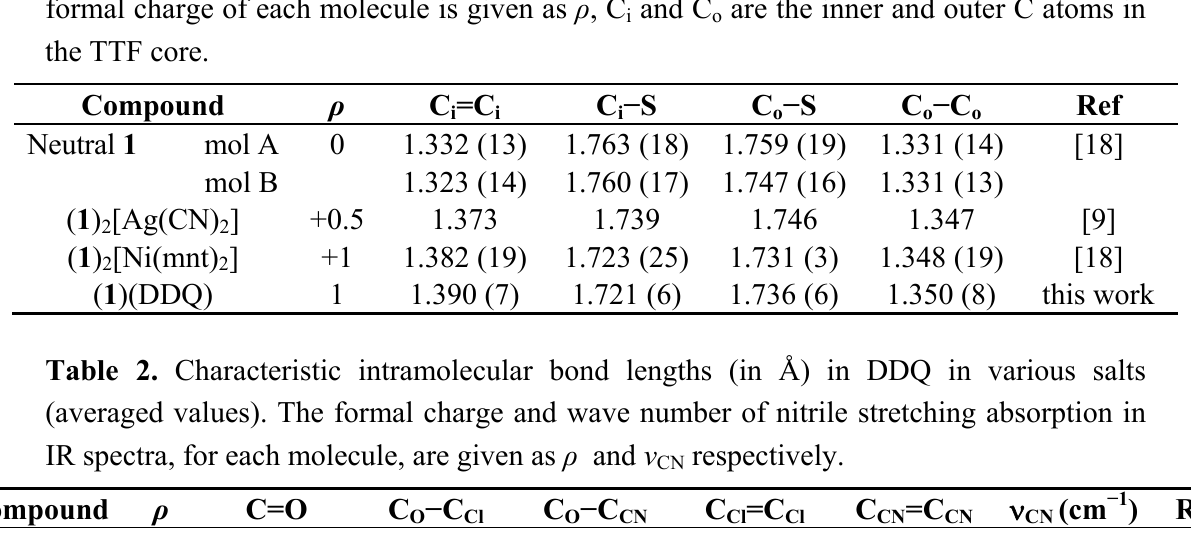
and C are the inner and outer C atoms in i o